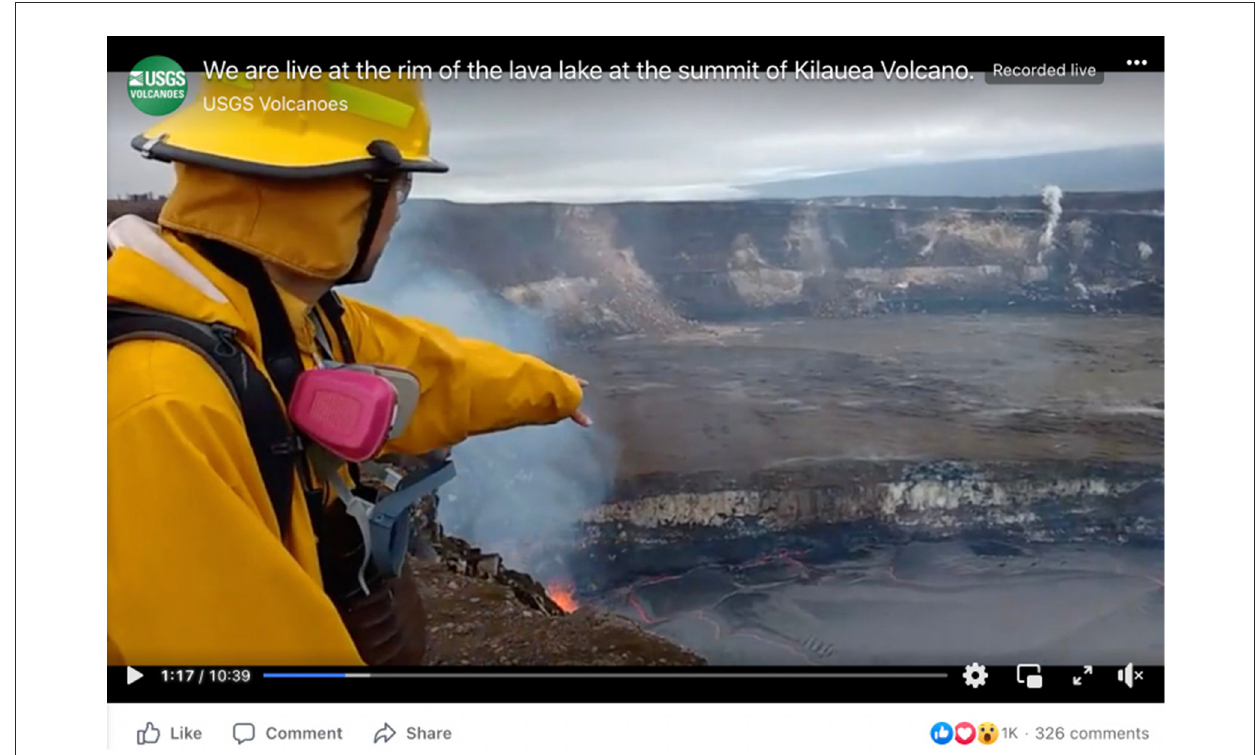
FIGURE2 Screenshot of a Facebook live event March 19, 2018, where an HVO geologist describes monitoring the rising lava lake. The event commemorated the 10-year anniversary of the Halema‘uma‘u eruption at the summit of K¯ılauea volcano. Total statistics for the two events: 405 comments, 1,370 likes, 60,400 views a, b . a https://www.facebook.com/watch/live/?ref=watch_permalink&v=1967239793304572; b https://www.facebook.com/